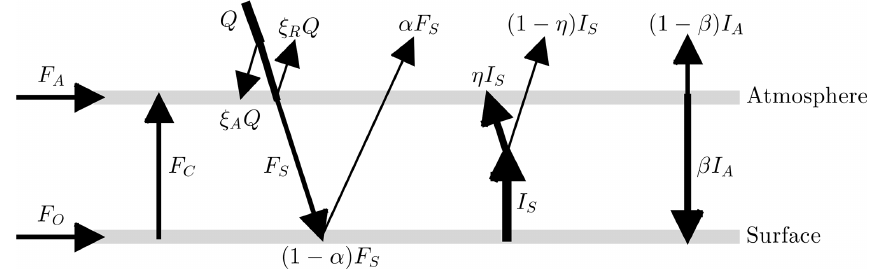
Figure 1. A visualization of the energy balance model (EBM). Here Q is the incident solar radiation. A fraction ξ A of Q is absorbed by the atmosphere and another fraction ξ R is reflected by clouds into space. The resulting solar forcing that strikes the surface is F S = ( 1 − ξ A − ξ R )Q . The surface has albedo α , which means that αF S is reflected back to space and the remaining energy ( 1 − α)F S is absorbed by the surface. The surface emits longwave radiation of intensity I S , of which a fraction ηI S is absorbed by greenhouse gases in the atmosphere and the remainder ( 1 − η)I S escapes to space. The atmosphere emits longwave radiation I A , of which a fraction βI A goes downward to the surface and the remaining fraction ( 1 − β)I A escapes to space. The three forcing terms ( F A , F O , F C ) represent atmospheric heat transport, ocean heat transport and vertical conduction/convection heat transport, respectively. Values of these and other parameters are given in Table